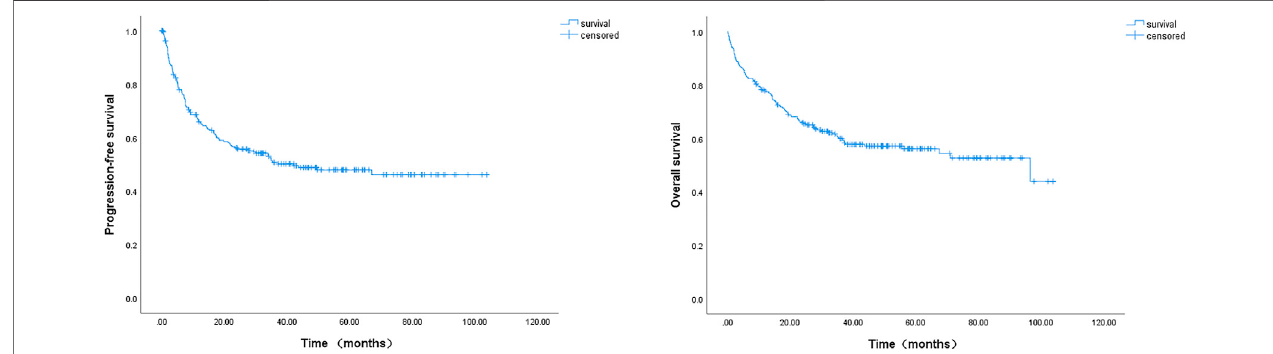
FIGURE 1 | Kaplan-Meier survival curve of progression-free survival (PFS) and overall survival (OS) of 239 DLBCL patients. The 2-year PFS and 2-year OS rates were 53.0% and 65.5%, the estimated 5-year PFS and OS rates were 44.7% and 56.1%, respectively; the median PFS and median OS were 42.1 and 96.4 months,